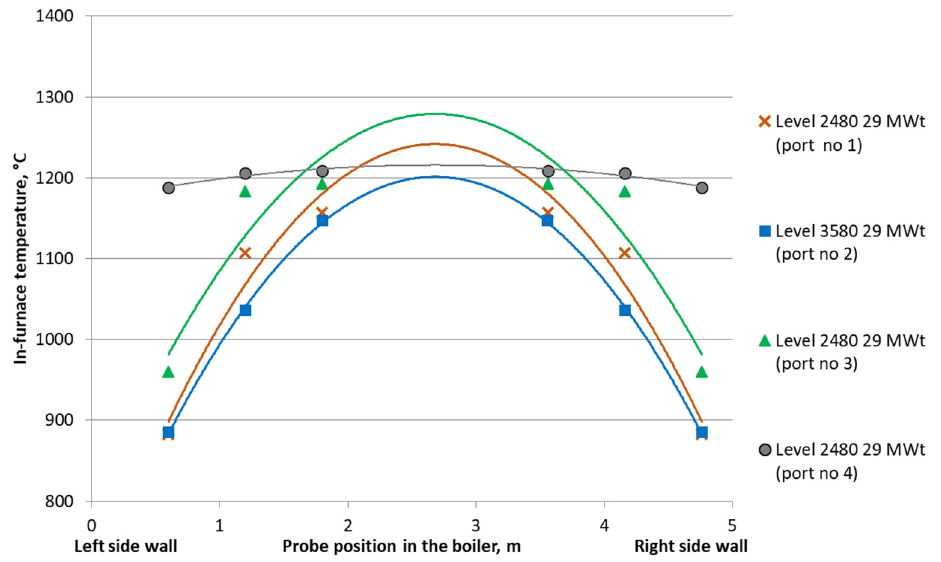
Figure 2. In-furnace corrected temperature values in ports no. 1–4 for boiler load of 29 MW th . Significant variability of the temperature profile can be seen at both 2480 and 3580 mm levels across and along the furnace which is expected in the case of the stoker boiler. At the beginning of the stoker (port no 4) temperature exceeds 1200 ◦ C and the temperature profile do not vary significantly, since the flame is shaped by the ignition arch. Along the grate length, the flame becomes less voluminous. The temperature profile changes: the temperature by the walls lowers and stays high in the center of the furnace, as measured in port 1 and port 3. Moreover, some air enters the furnace through the outermost parts of the grate and thus the temperature near the walls is lower. The average in-furnace temperature in the middle of the stoker (ports no. 1 and 2) shows that for the maximum boiler load the flue gas temperature at the level 3580 mm is above 1020 ◦ C and at 2480 mm it reaches 1050 ◦ C. Based on the measurements, the expected temperature window for minimum and maximum boiler loads can be determined and the most optimal level of sorbent injection can be defined. HALKORNOKS tests took place at a high boiler load, so level 4730 mm was chosen. The temperature measurement at this level was not possible due to insufficient space around the boiler. However, the measurement at levels 2480 and 3580 mm indicated that the sorbent injection should be realized at a higher level and the level of 4730 was the only injection location available.